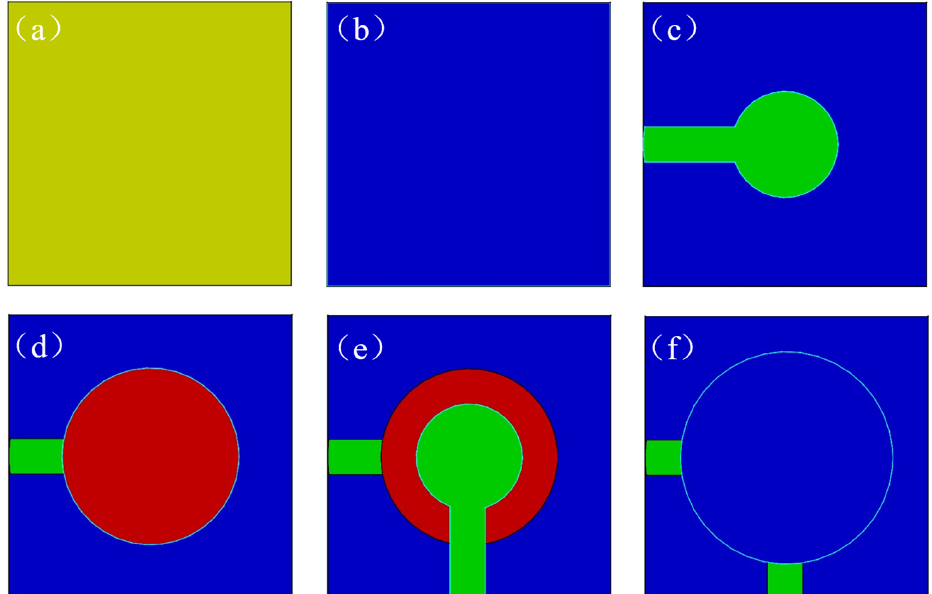
Figure 4. The primary fabrication process of the piezoelectric film sensor on GH4169 superalloy steel substrate: ( a ) polishing and cleaning of the substrate; ( b ) deposition of SiO 2 insulating layer without a stainless-steel mask plate (SSMP); ( c ) preparation of NiCr bottom electrode film on SiO 2 insulating layer; ( d ) the sputtering of the ZnO piezoelectric layer; ( e ) preparation of NiCr top electrode film on ZnO piezoelectric layer; ( f ) growing SiO 2 protective layer film.